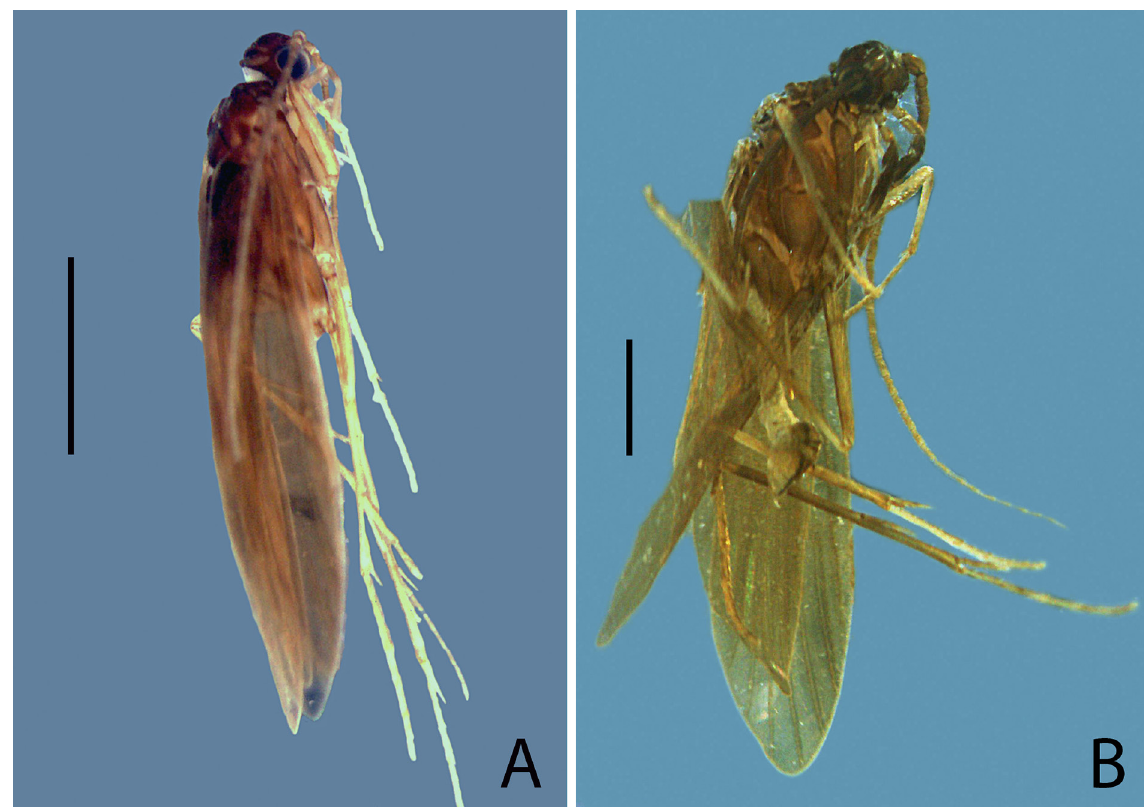
Fig. 2. Xiphocentronidae spp., adult ♂♂, habitus. A . Machairocentron amahuaca sp. nov., paratype (MUSM). B . Xiphocentron harakbut sp. nov., holotype (MUSM-ENT-03205564). Scale bars: 1